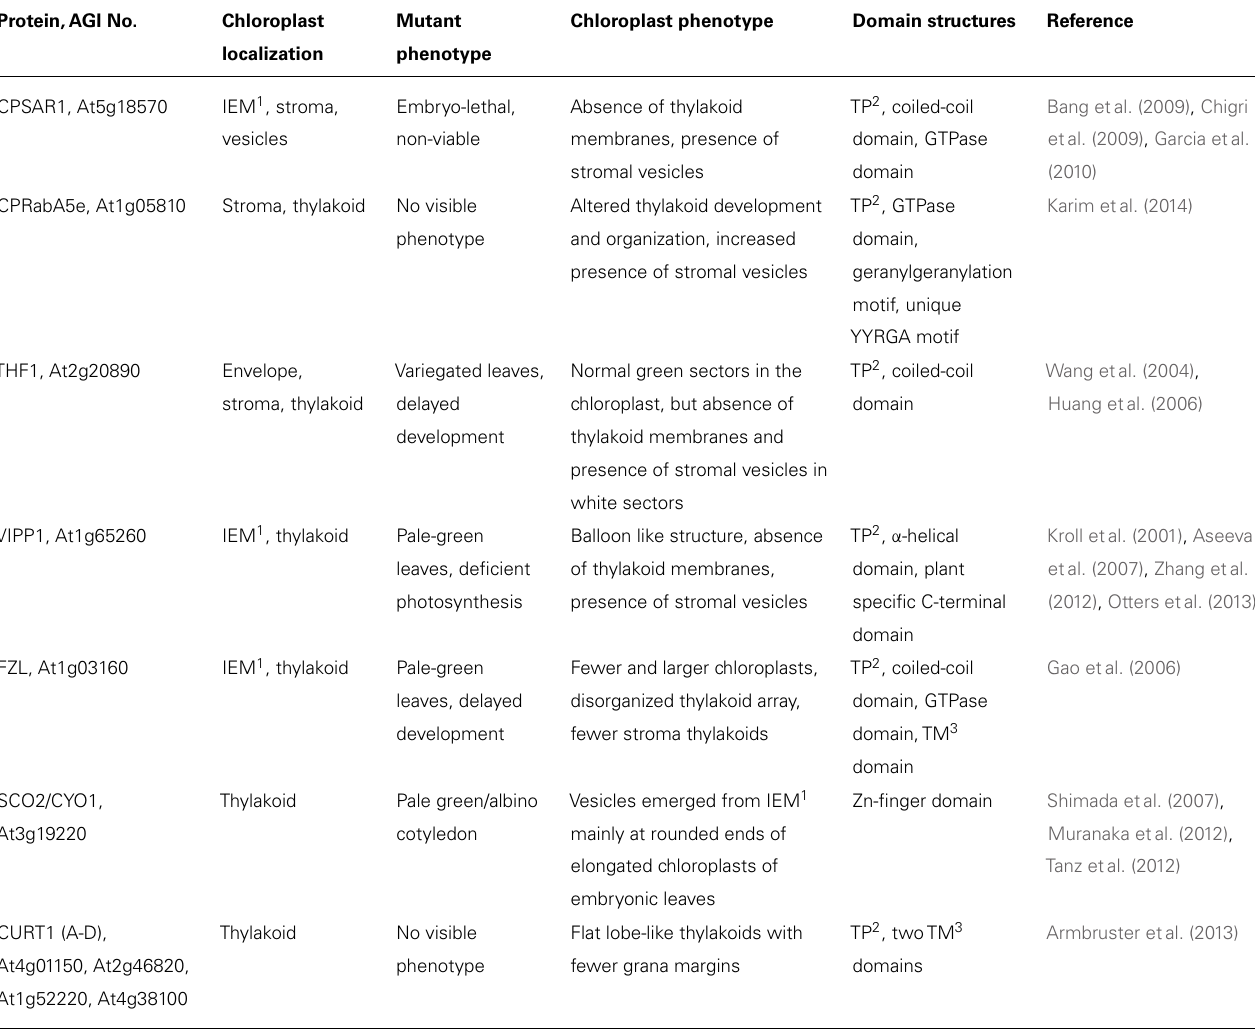
Table 1 | Chloroplast localized proteins putatively involved in chloroplast vesicle transport. Protein,AGI